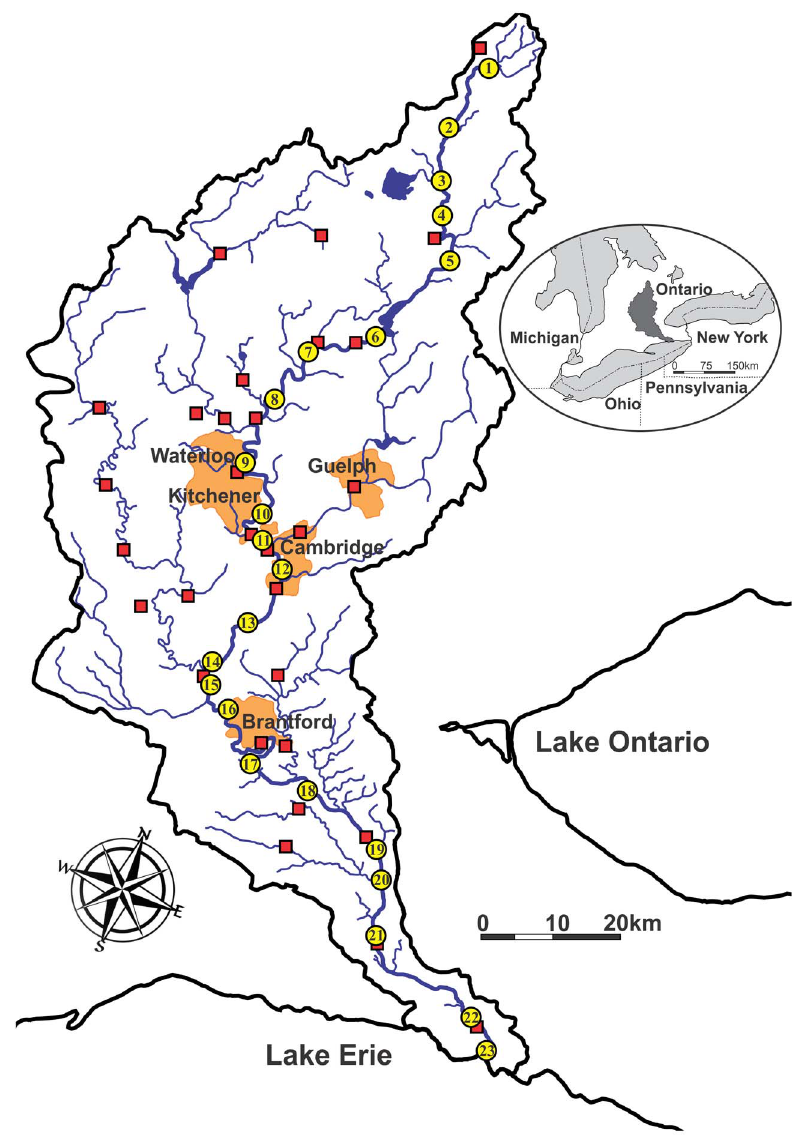
Figure 1. Grand River Watershed (6,800 km 2 ), Ontario, Canada . Numbered circles and red squares indicate the 23 sampling sites and 30 WWTPs, respectively. Site numbering starts in the headwaters and increases downstream, terminating at Port Maitland where the Grand River discharges to Lake Erie. The 3 largest WWTPs by rated capacity are Kitchener, Brantford and Waterloo.